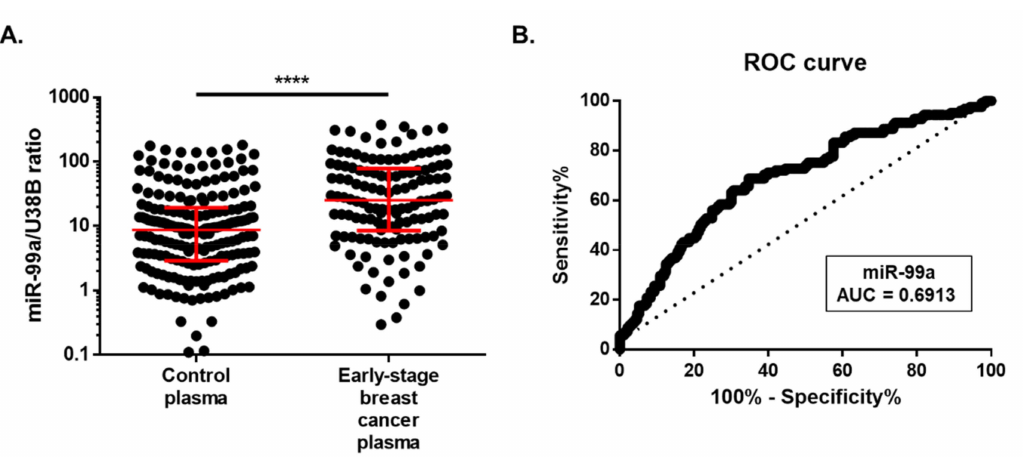
Figure 5. ( A ) Expression of miR-99a in early-stage breast cancer plasma. Distribution of circulating miR-99a levels in 125 plasma of early-stage breast cancer patients (stage I and II) and 193 healthy controls. Expression levels were significantly lower in healthy controls than in early-stage breast cancer patients. Horizontal line: median with interquartile range. Mann–Whitney U, **** p < 0.0001. ( B ) Receiver-operating characteristic (ROC) curve analysis for circulating miR-99a levels in early-stage breast cancer